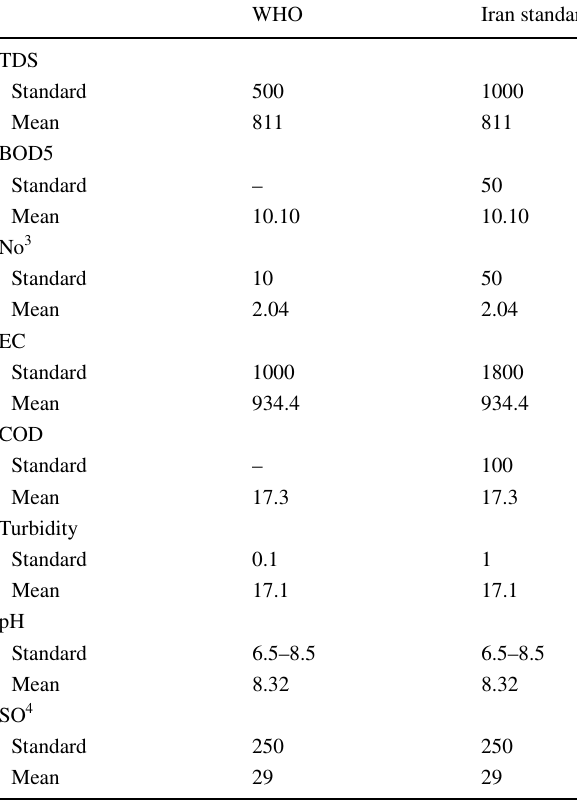
Table 4 One-sample t test to compare the physicochemical values of Balikhlou River with national and international standards in low- water season